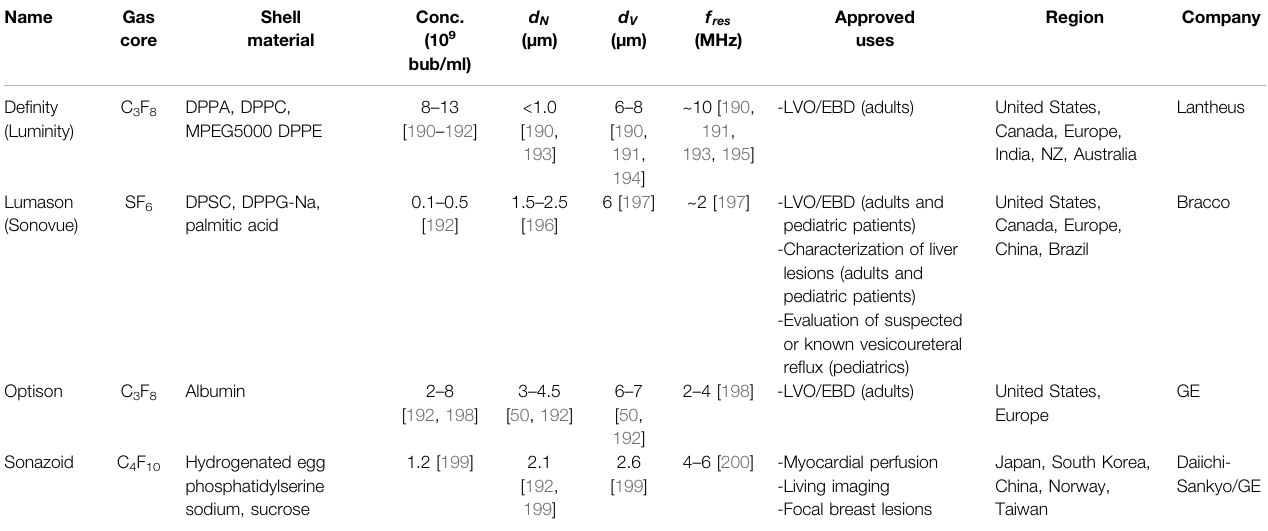
TABLE 1 | Current clinical contrast agent microbubbles, their salient characteristics, and their approved